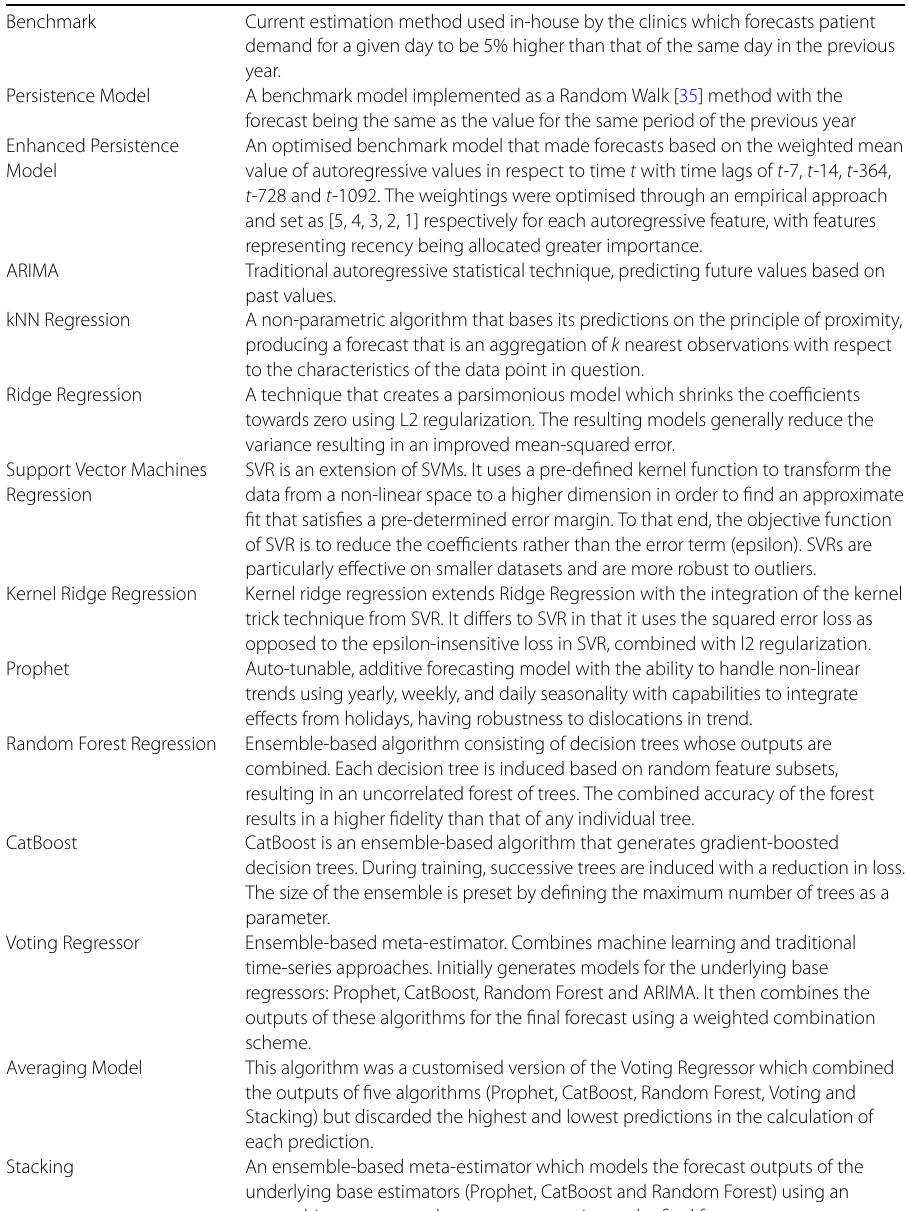
Table 3 Summary of the benchmark models and algorithms used in this study, together with hyperparameter settings where